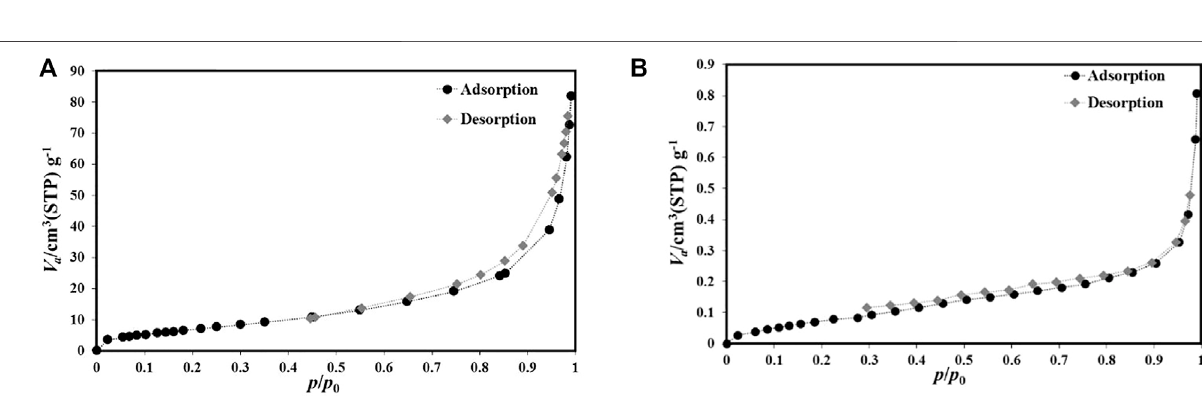
Frontiers in Chemistry |